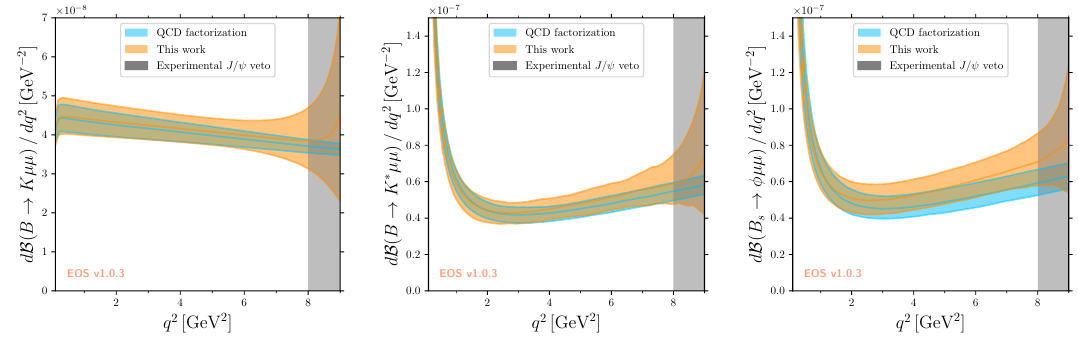
Figure 3 . Comparison between our SM predictions for the differential branching ratio in the three channels and the result obtained in QCD factorization [22, 46], including the form-factor relations in the large-energy